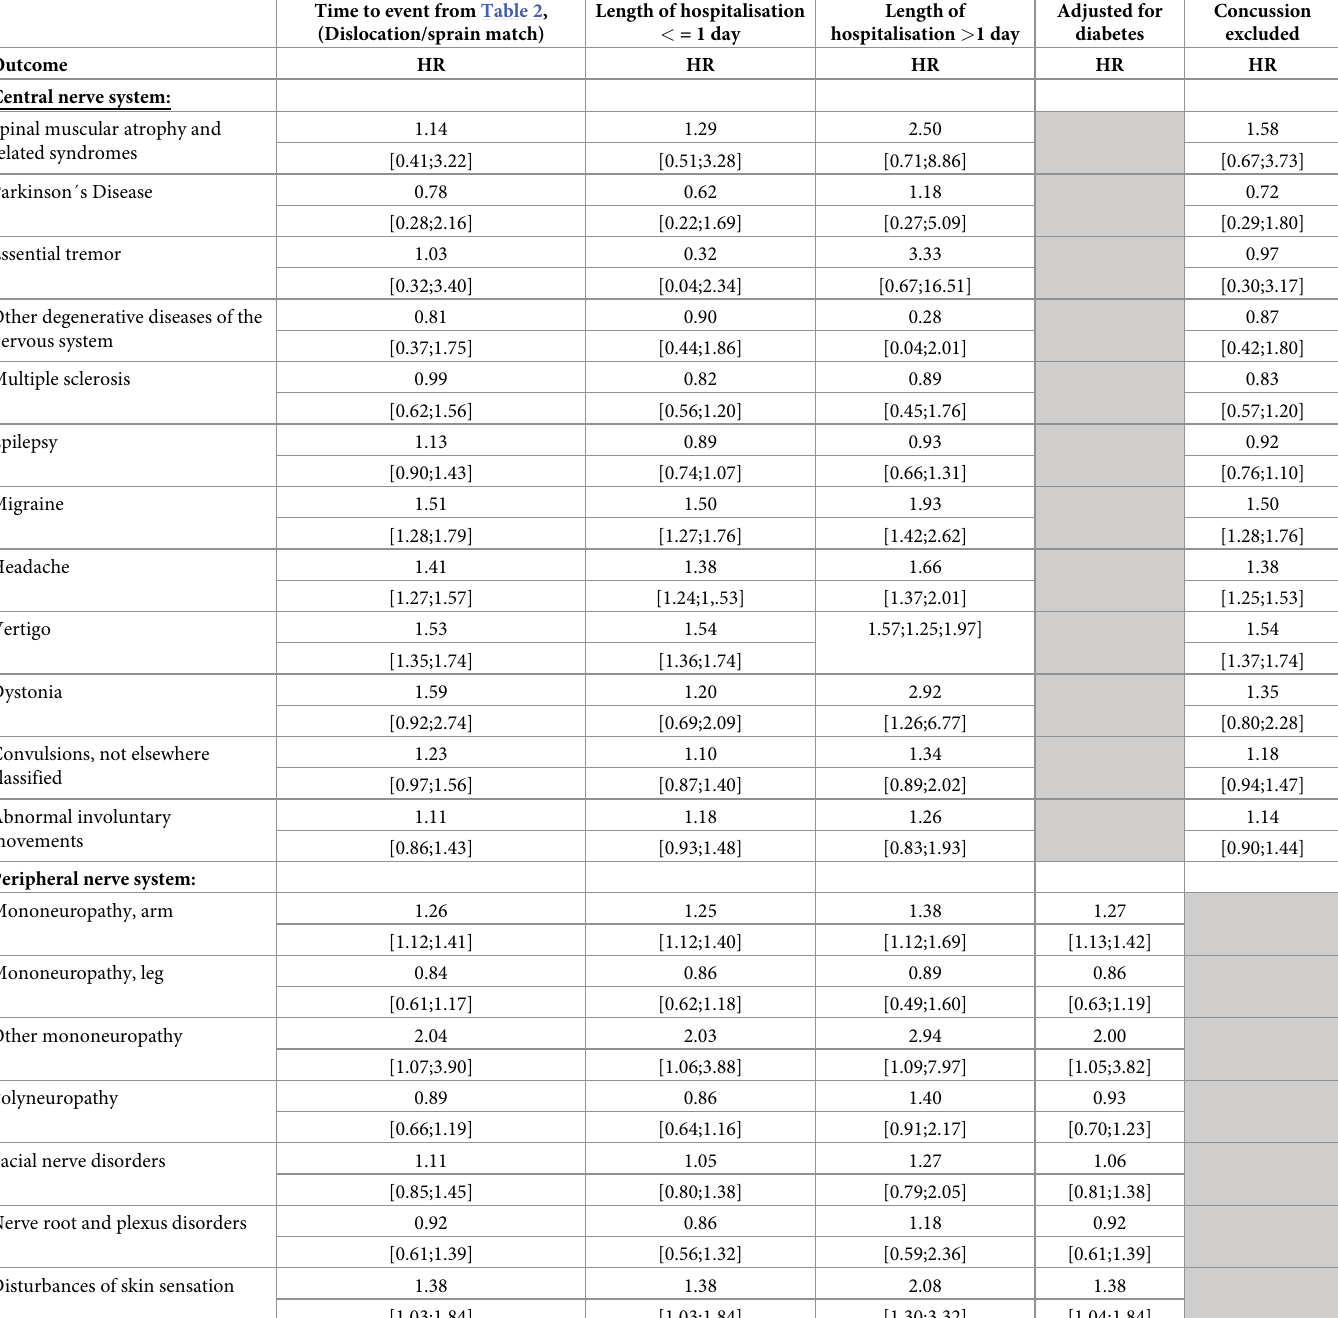
Table 3. Sensitivity analyses (electrical injuries matched with dislocation/sprain controls). Stratified on length of hospitalisation, adjusted for diabetes and with exclu- sion for concussion in connection to the injury. Time to event from Table 2, (Dislocation/sprain